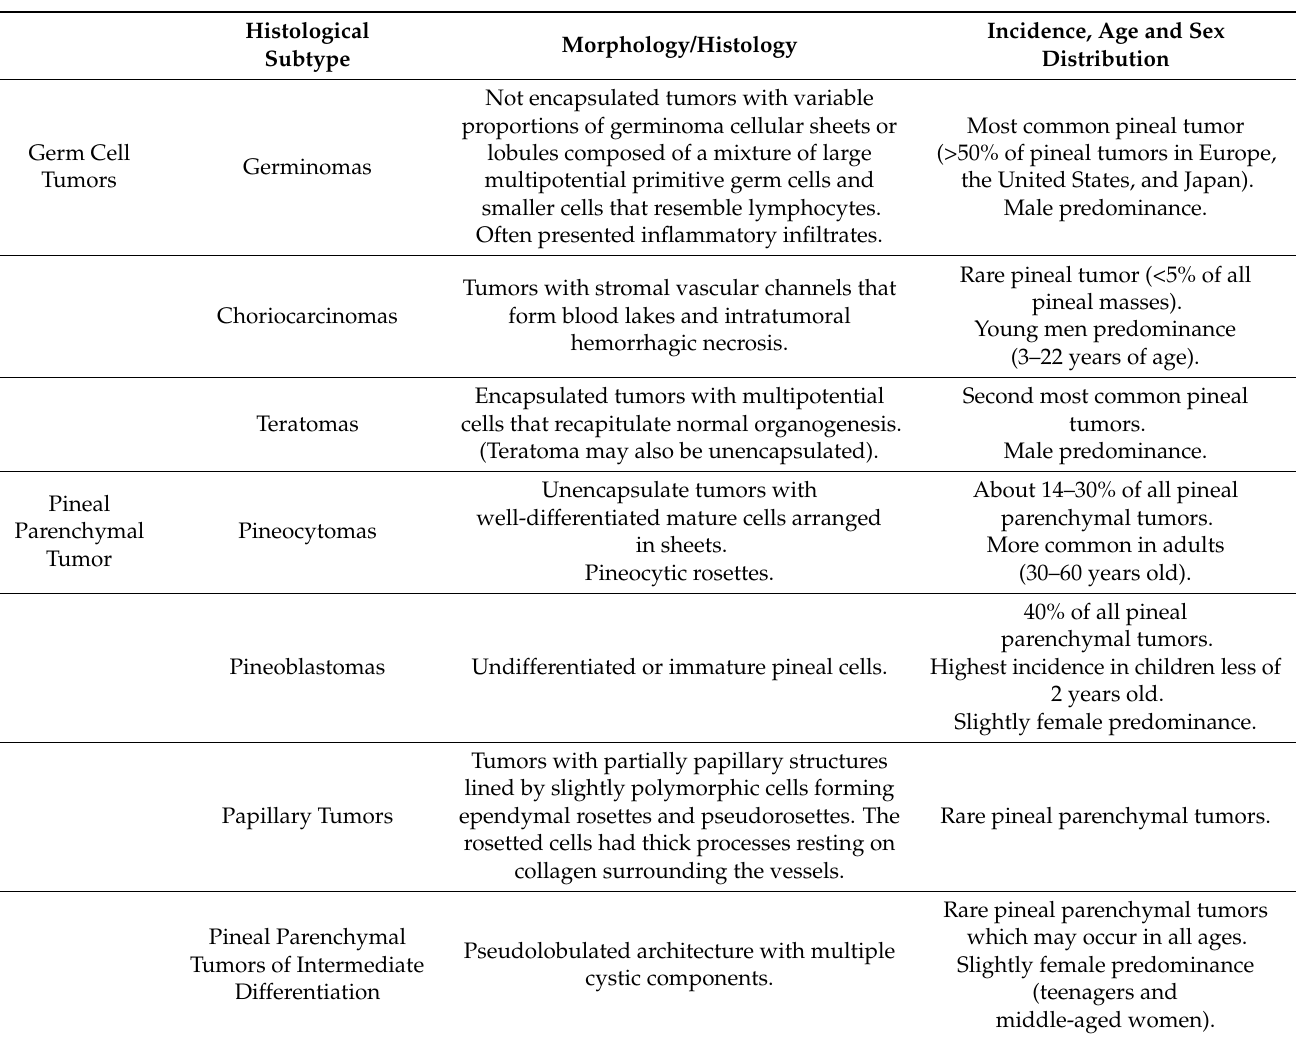
Table 1. The table summarizes the main characteristics of pineal gland